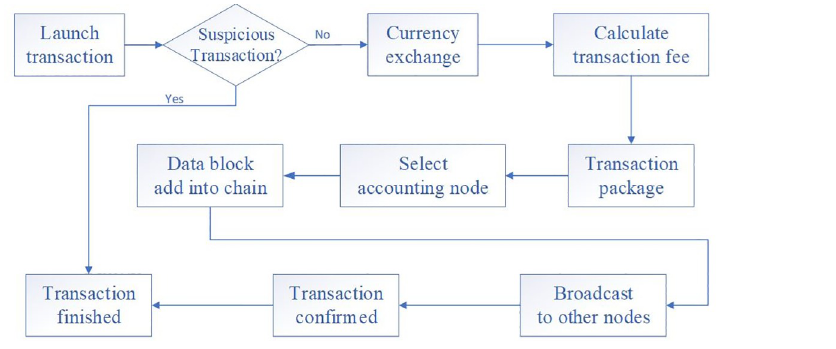
Fig 3. Transaction process with blockchain